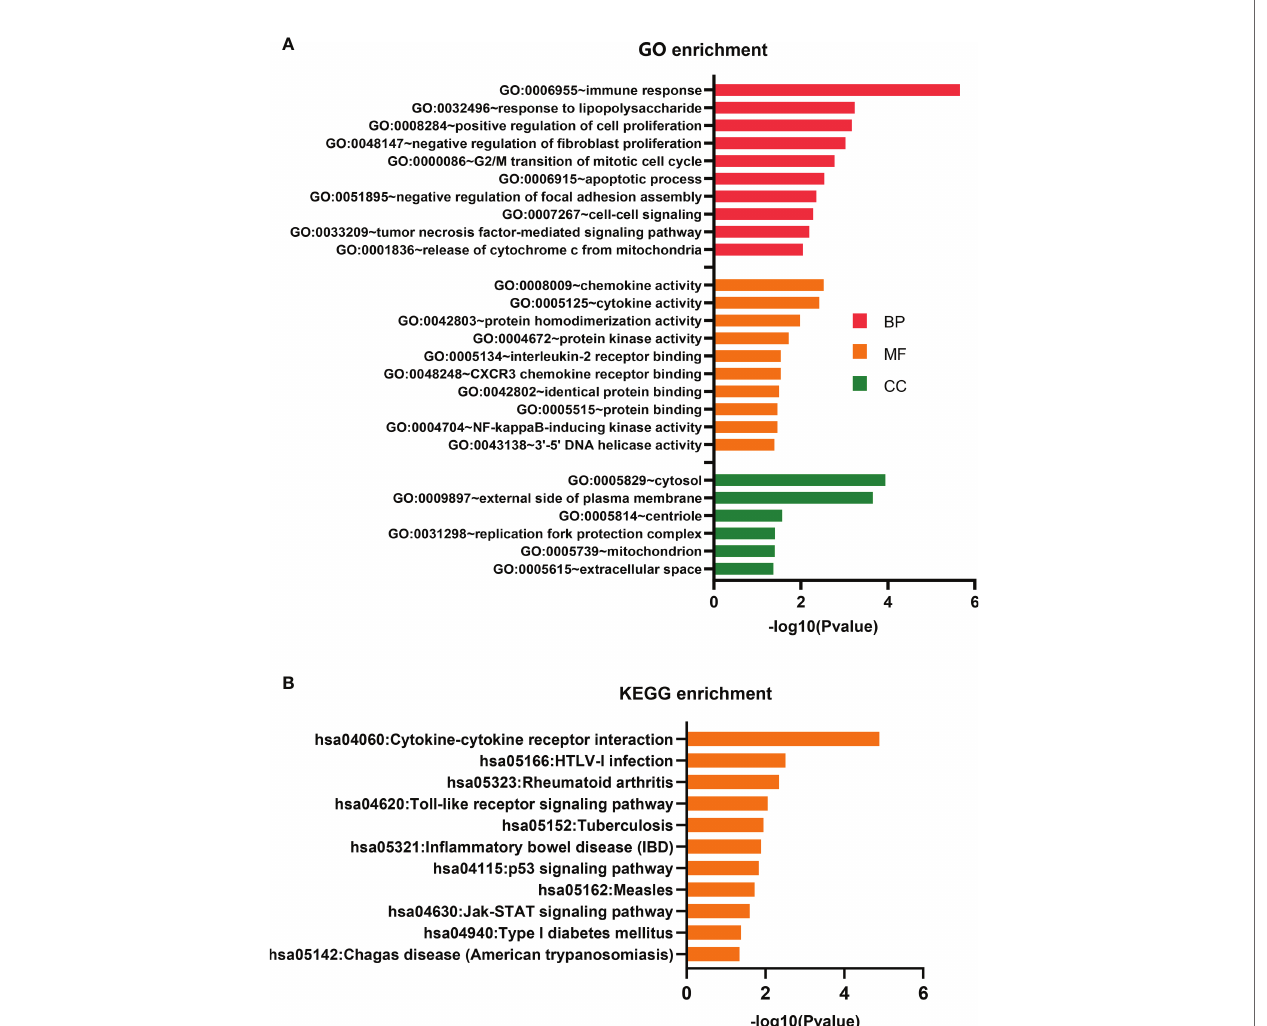
FIGURE 4 | GO terms and KEGG pathway analyses. (A) GO term enrichment analysis. (B) KEGG pathway enrichment